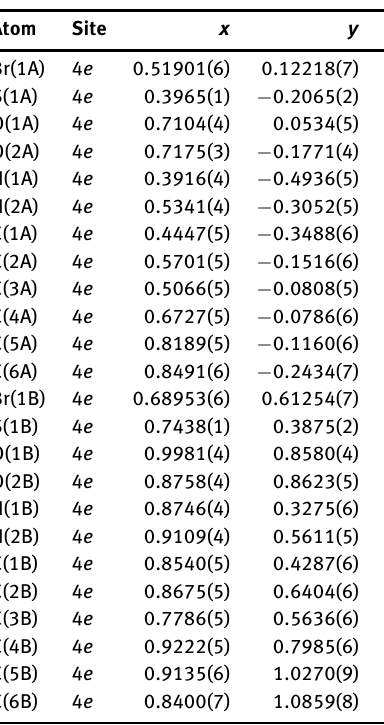
Table 3: Fractional coordinates and atomic displacement parameters (Å 2